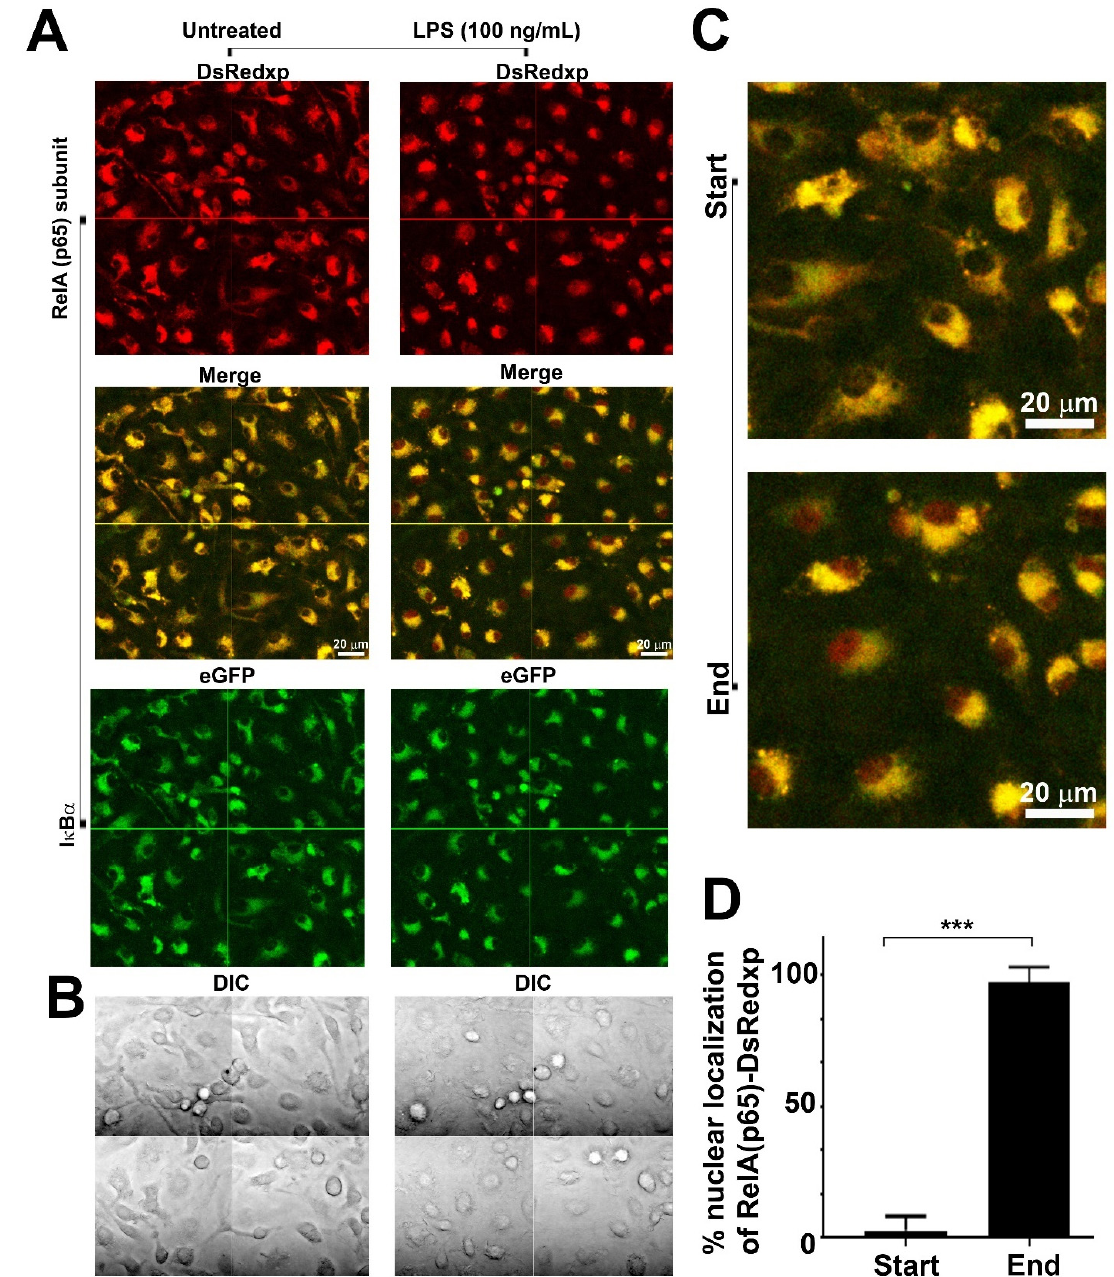
Figure 1. Confocal microscopy shows p65-DsRedxp translocation from the cytoplasm to the nucleus of bone marrow-derived macrophages (BMDMs) from p65-DsRedxp/I κ B α -eGFP mice following stimulation with bacterial lipopolysaccharide. Bone marrow cells from frozen stocks were differentiated in vitro to macrophages as described in Materials and Methods. Live macrophages were monitored at rest for 40 min before being stimulated with lipopolysaccharide (LPS), at 100 ng/mL, and continuously monitored for over 5 h. Confocal imaging (using a 63x oil immersion objective) showing composite images of 4 fields, of untreated and post LPS-treatment of BMDMs: ( A ) upper panel, red channel showing p65-DsRedxp localisation; middle panel, red (DsRedxp) and green (eGFP) channels superimposed (Col RG) and, lower panel, green channel, showing I κ B α -eGFP localisation in the cytoplasm. ( B ) Differential interference contrast (DIC) imaging of macrophages. ( C ) Higher magnification of the Col RG channel, and ( D ) histogram illustrating % of cells with p65-DsRedxp observed in the nucleus at rest (start), and following TLR4 activation (end); ( n = 36; *** p < 0.001, unpaired t -test). Bar = 20 µ